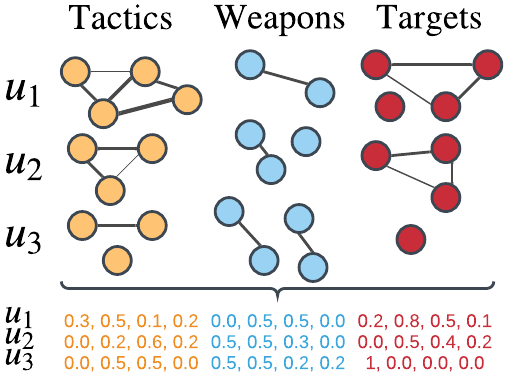
Figure 3. Sample visual depiction of the transformation of temporal meta-graphs in each dimension across u time-units in multivariate time-series capturing the normalized degree centrality of each feature in each dimension across the same u time units. The figure has been created using Lucidchart. https:// www. lucid chart. com.